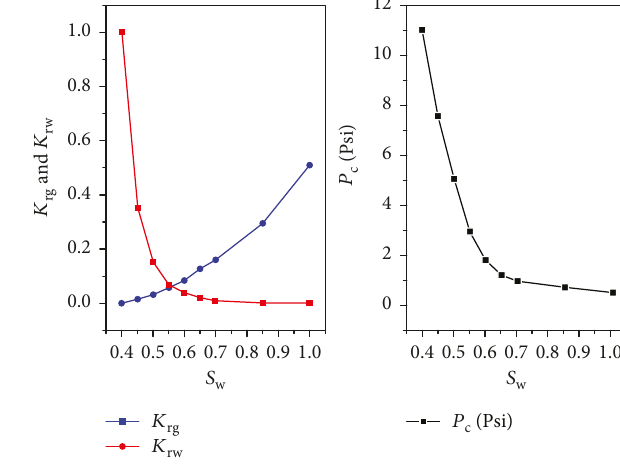
Figure 3: The oil/water relative permeability curve and capillary pressure.